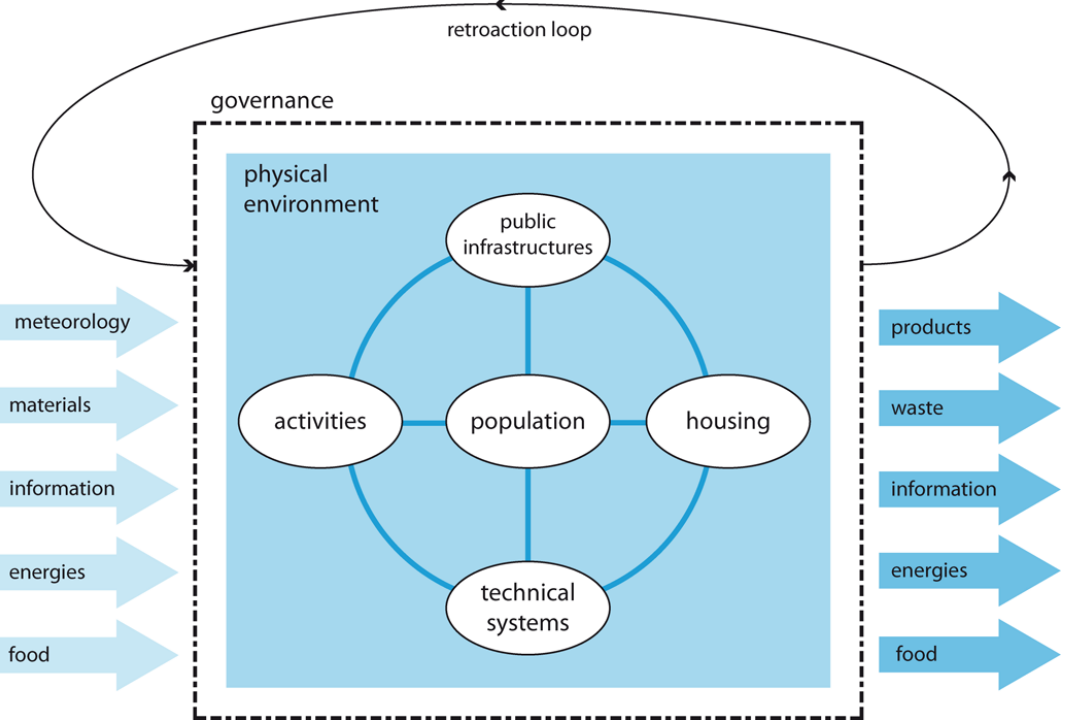
Fig. 1. City system as an input-output model (source: Lhomme